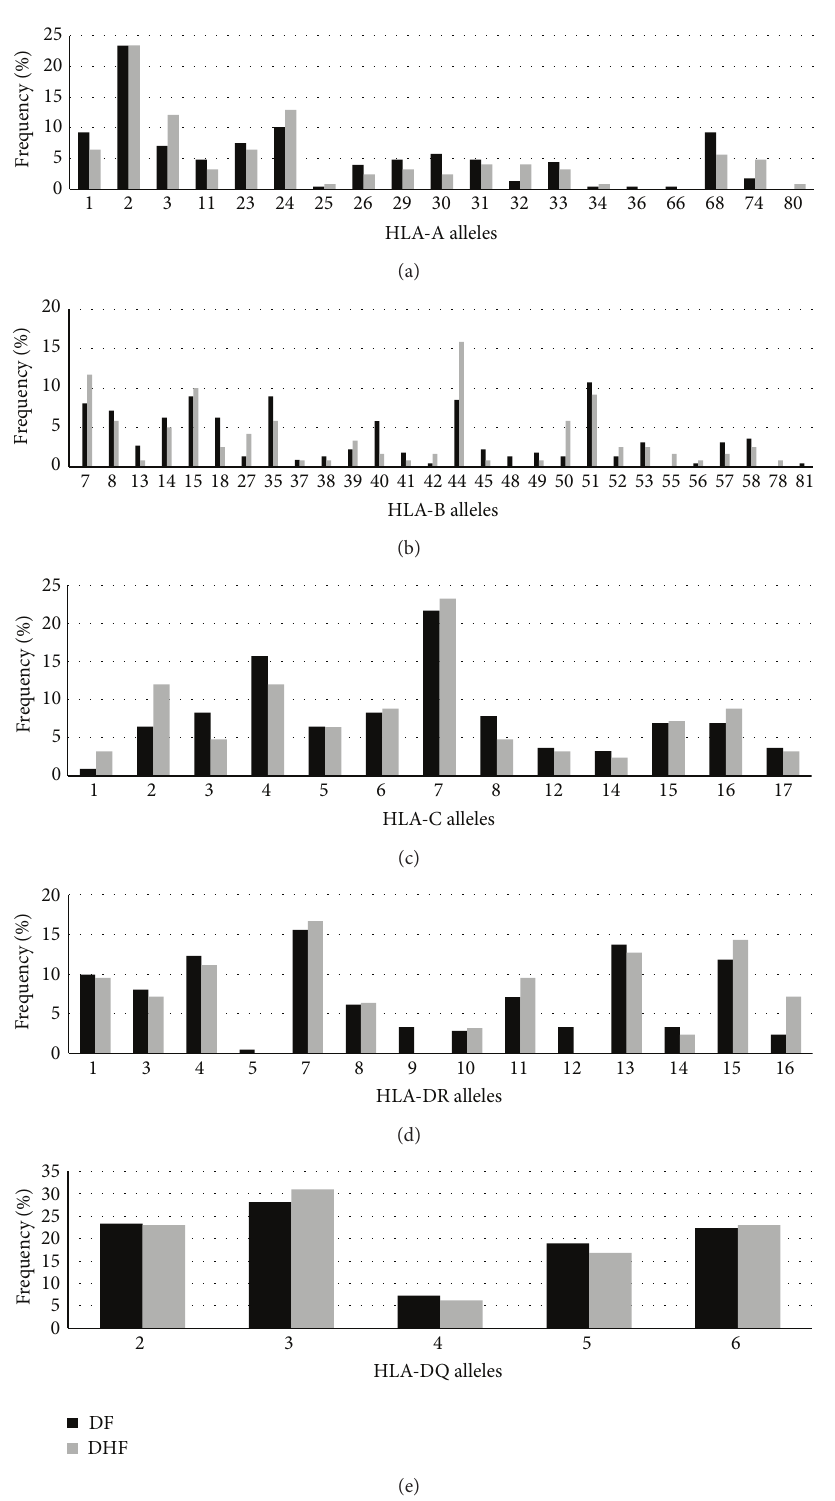
Figure 3: Allele versus DF-DHF frequency for HLA in the study population. (a) HLA-A, (b) HLA-B, (c) HLA-C, (d) HLA-DR, and (e) HLA-DQ. DF: dengue fever; DHF: dengue hemorrhagic